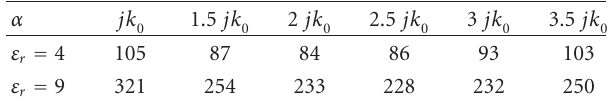
Table 2: Iteration number required by FETI-DPEM2 for dielectric cube with di ff erent materials versus α .